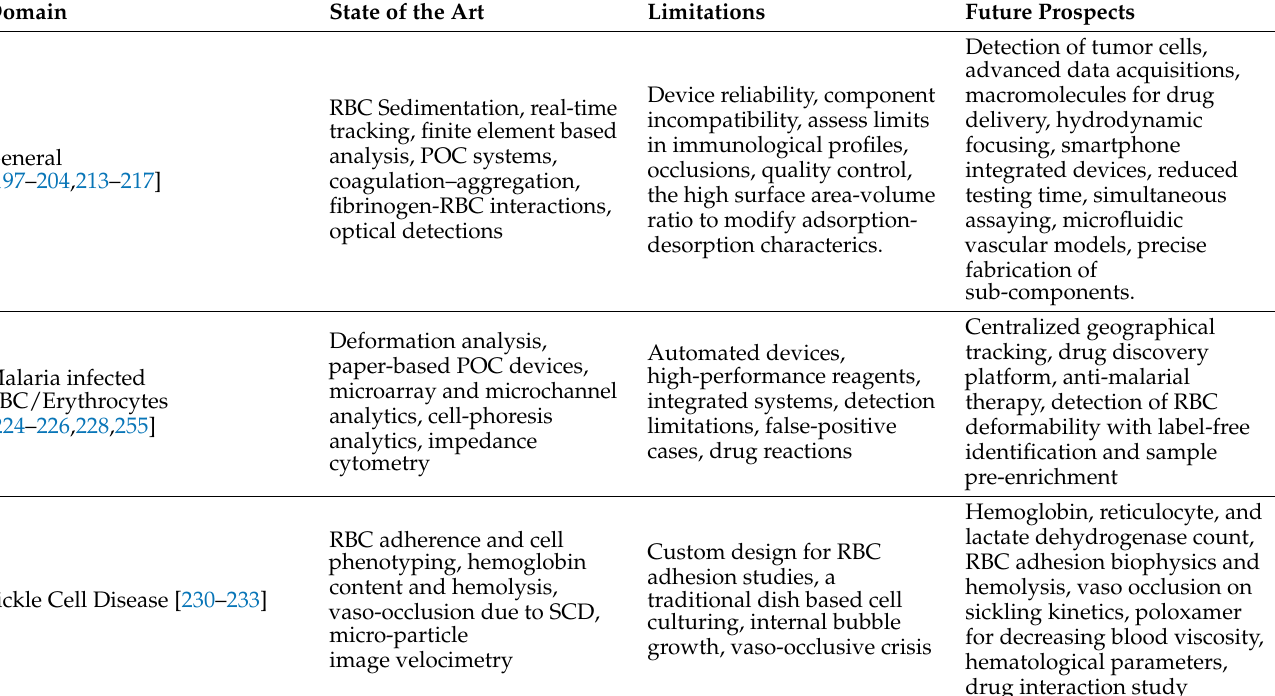
Table 2. Microfluidic devices for RBC Assessments in Clinical